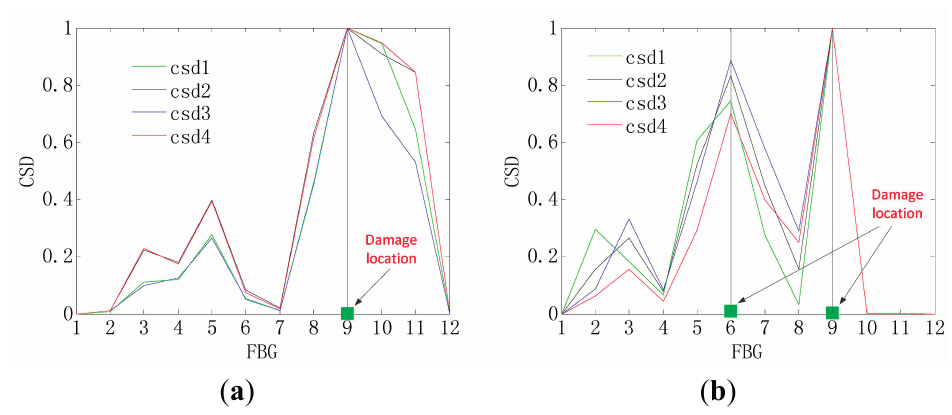
Figure 5. CSD for two-damage detection.